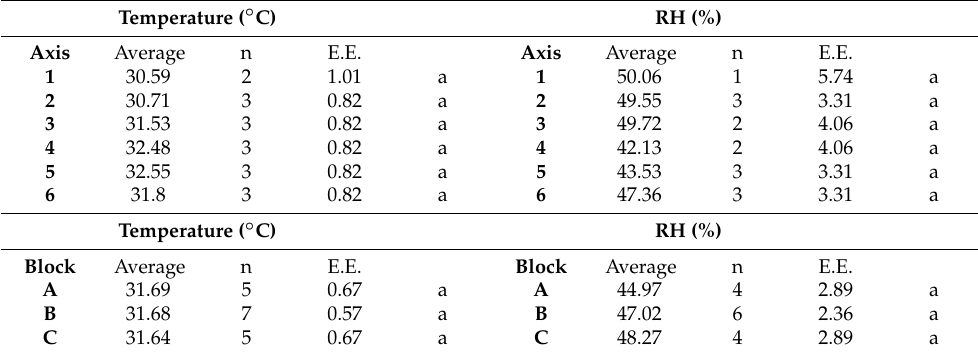
Table 3. Tukey’s method for the case I analyses the temperature and relative humidity variance between axes and